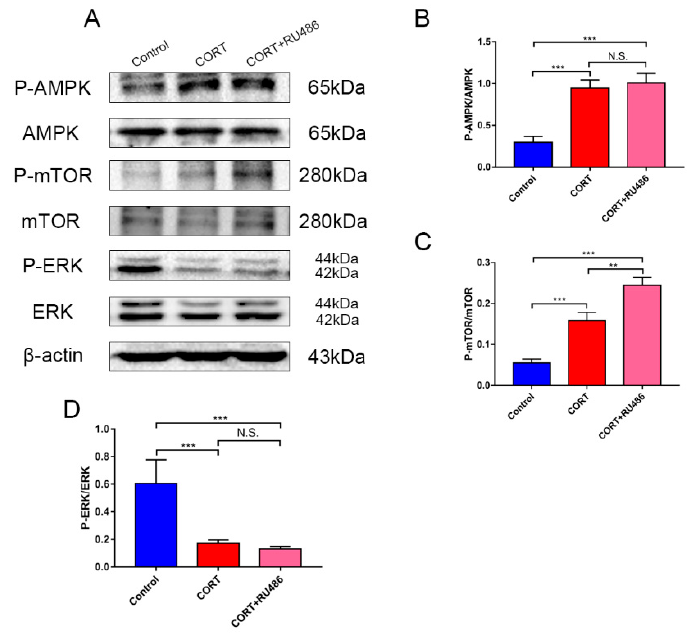
Figure 11. The relevant signaling pathway expression of key proteins in HT22 cell lysates after cortisol treatment for 3 h as assessed by western blotting and relative density analyses. ( A ) AMPK, P-AMPK, mTOR, P-mTOR, ERK, P-ERK, and β -actin expressions in each group. Expression levels were quantitated by measuring band intensities using Image Lab software. The graphs indicate densitometric analyses using the expression ratios of ( B ) P-AMPK / AMPK, ( C ) P-mTOR / mTOR, and ( D ) P-ERK / ERK. The results are expressed as the mean ± SD (n = 3) in each independent experiment analyzed by one-way analysis of variance. NS: not significant; * p < 0.05; ** p < 0.01;.